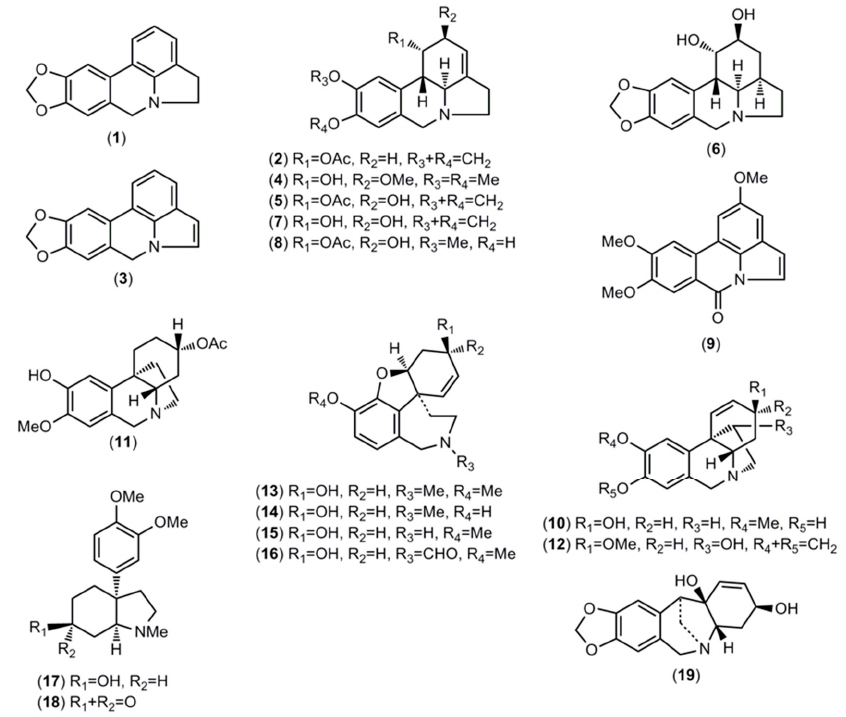
Figure 2. Alkaloids identified in Ecuadorian Phaedranassa Herb. by gas chromatography coupled to mass spectrometry (GC-MS).